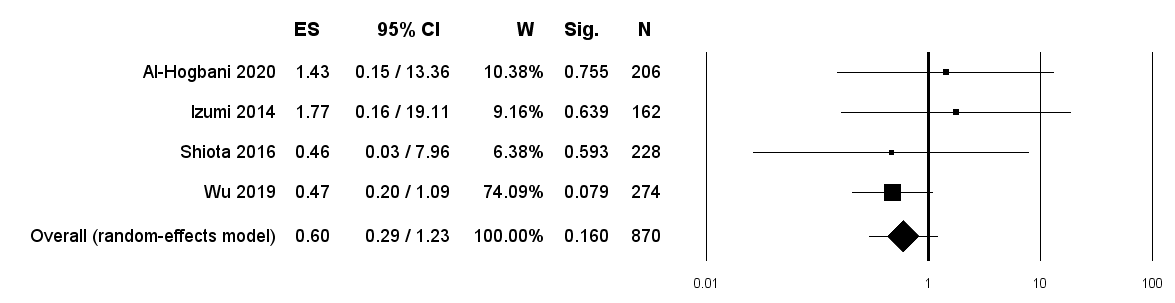
Figure 4. Metaregression of the proportion of patients with T1 BCa among those treated with 5-ARIs / proportion of patients with T1 BCa among those not treated with 5-ARIs and the RR of BCa recurrence on the RR of BCa recurrence (y = − 7.44 + 7.07 x, p = 0.014).